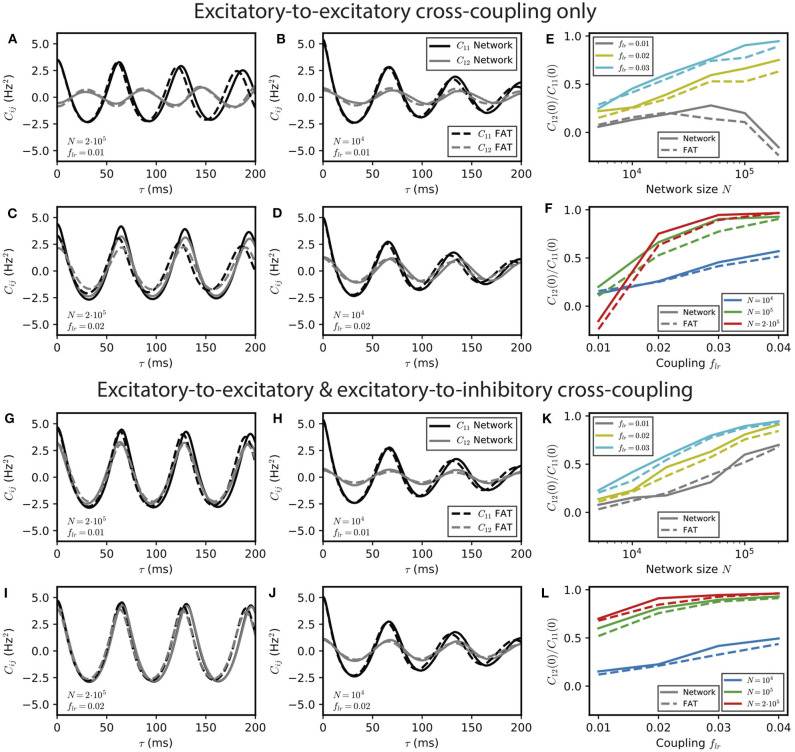
Stochastic effects due to network size for two E–I modules coupled by long-range excitation. Auto- and crosscorrelations C11 and C12 of the activities of E–I modules with a finite number of neurons N = 104 and 2 · 105 for different coupling strengths flr = 0.01 and 0.02 with long-range excitation targeting only excitatory populations (A–D) or targeting both excitatory and inhibitory neurons (G–J) (parameter values are stated in the panels' lower left corner). Summary plots with the ratio of equal-time cross-correlations over autocorrelations for varying N and flr are shown in (E,F,K,L), respectively. In the E → E case, oscillatory synchrony between the two modules disappears when the coupling strength flr diminishes [(C) vs. (D)], but the dynamical regimes of Figure 2 are blurred by stochastic effects when the network size N decreases [(A,B) vs. (C,D)]. In the E → E, I case, no other dynamical regimes than oscillatory synchrony are expected, but synchrony increases both with coupling strength flr, and more strongly, with network size N.